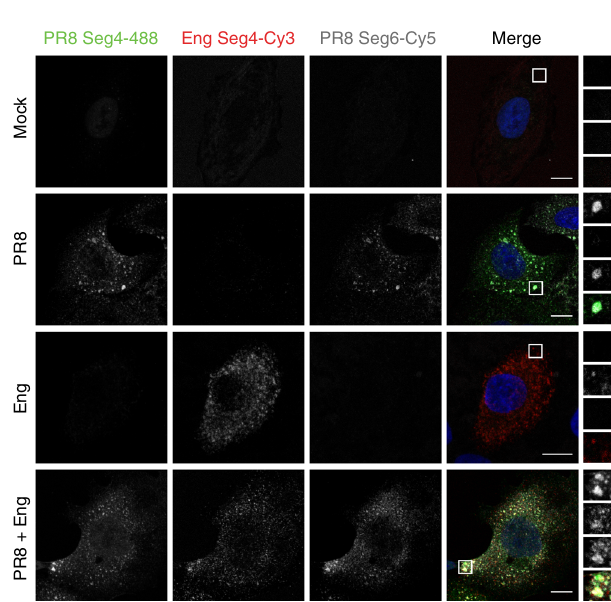
Fig. 9 Viral inclusions harbor vRNPs of two parental viruses in co-infections. A549 cells were mock infected or infected with PR8 and/or Eng2009, at an MOI of 3, each. At 16 hpi, cells were fi xed and processed for FISH to detect segments 4 of both viruses and segment 6 of PR8. Inlets show magni fi cations with all segments colocalizing in co-infections, and segment 4 and 6 upon PR8 challenge. 10 cells were analyzed per